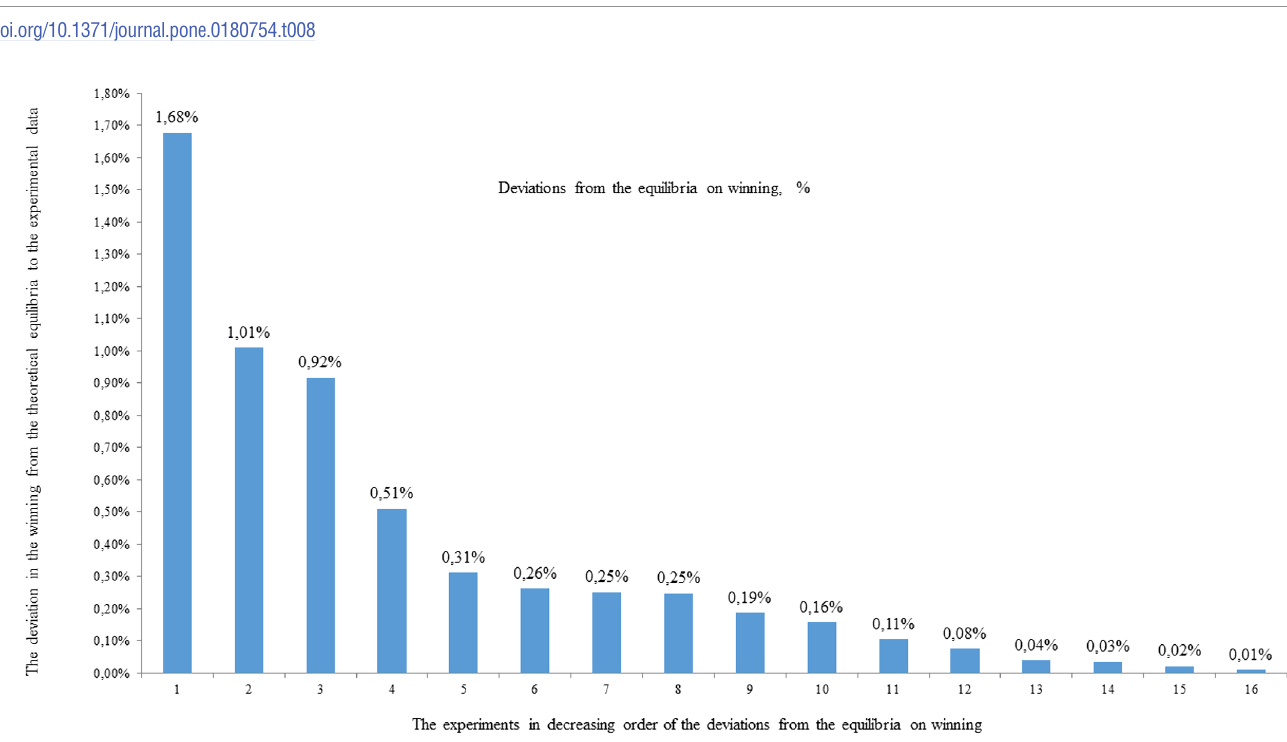
Fig 6. Deviation of experiments from the equilibria on winning in percentages. The deviationin winningin the experimental data from the theoretical equilibrium(y-axis) duringthe experiments in decreasing order of the deviationsfrom the equilibriain winning(x-axis). https://doi.org/10.1371/journal.pone.0180754.g006 PLOS ONE | https://doi.org/10.1371/journal.pone.0180754 November30,